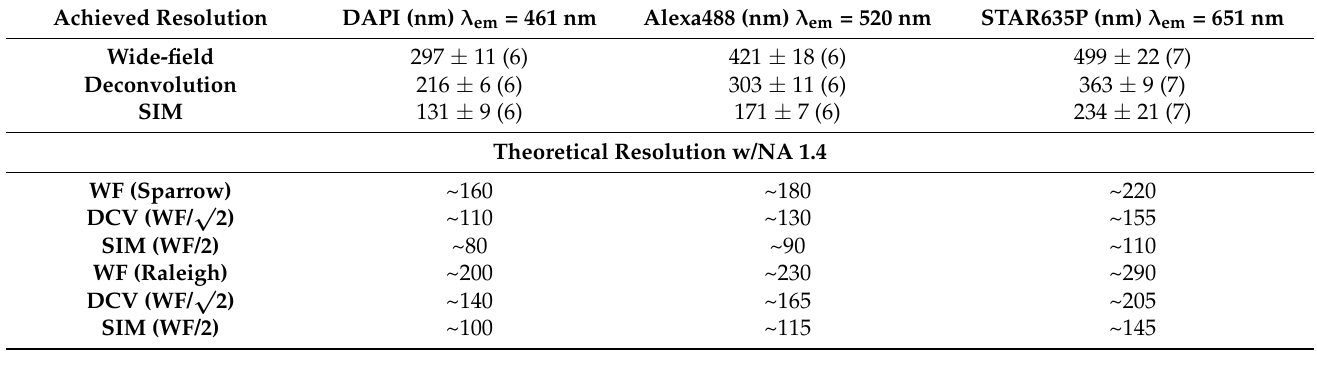
Figure 1. Distribution of topoisomerase II (Topo II) in barley metaphase chromosomes visualized by wide-field, deconvolution, and structured illumination microscopy (SIM) using Alexa488-la- beled secondary antibodies. Topo II is accumulated at the subtelomeres (arrows) and the centro- mere by surrounding it. The enlarged regions (dashed rectangles) show clearly the improved reso- lution of Topo II and DAPI(4 ′ ,6-diamidino-2-phenylindol)-labelled chromatin structures via SIM. Only one representative slice from the Z image stack is shown in all images. Table 2. Maximal achieved lateral resolutions in wide-field, deconvolution, and SIM images after applying different fluorescence dyes in comparison to the theoretically possible resolutions. The numbers of measured chromosomes are in parentheses.